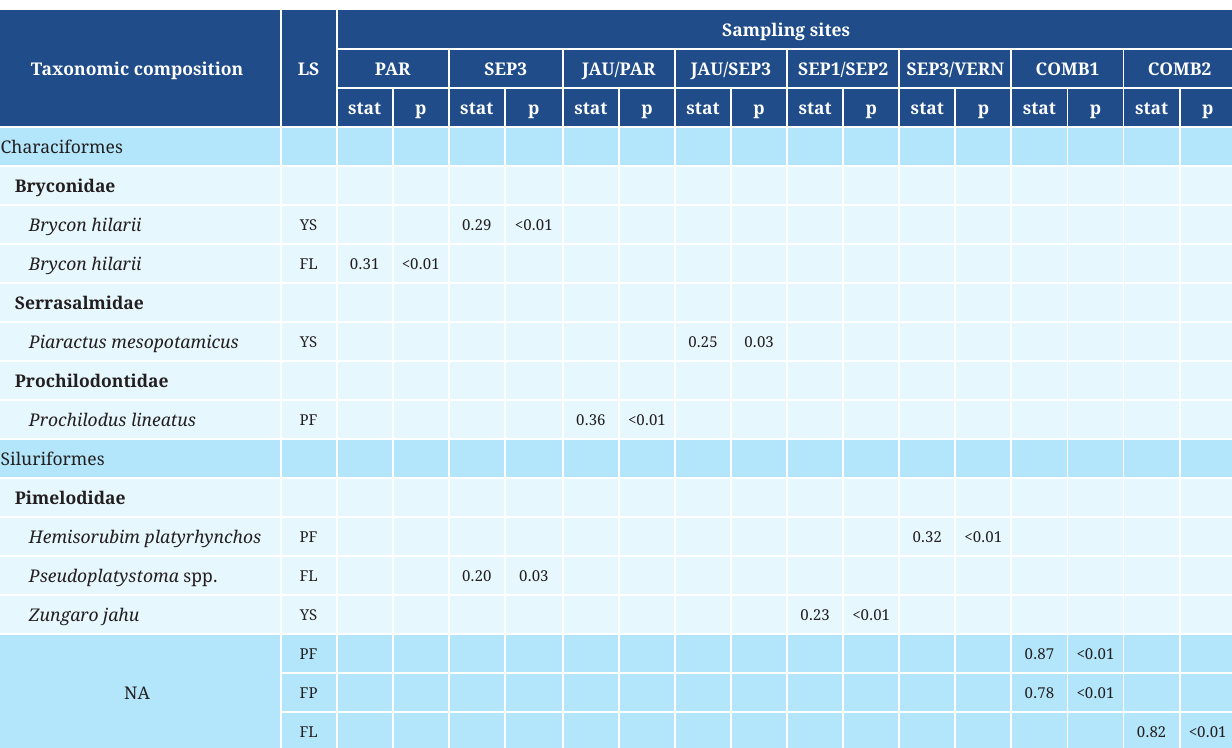
TABLE 2 | Significant indicator species values (IndVal) recorded at the sampling sites in the upper Paraguay River basin in two breeding seasons (2017–2018 and 2018–2019) in Mato Grosso State, western Brazil. CAB1 = Cabaçal River site 1; CAB2 = Cabaçal River site 2; FOR = Formoso River; JAU = Jauru River; JUB = Juba River; PAR = Paraguay River; SEP1 = Sepotuba River site 1; SEP2 = Sepotuba River site 2; SEP3 = Sepotuba River site 3; VERN = Vermelho River; COMB1 = association among sites CAB2/JAU/PAR/SEP3; COMB2 = association among sites CAB2/JAU/ PAR/SEP3/VERN; LS = larval stage; stat = statistic; p = significance level; NA = not analyzed; YS = yolk-sac; PF = preflexion; FL = flexion; FP = postflexion.